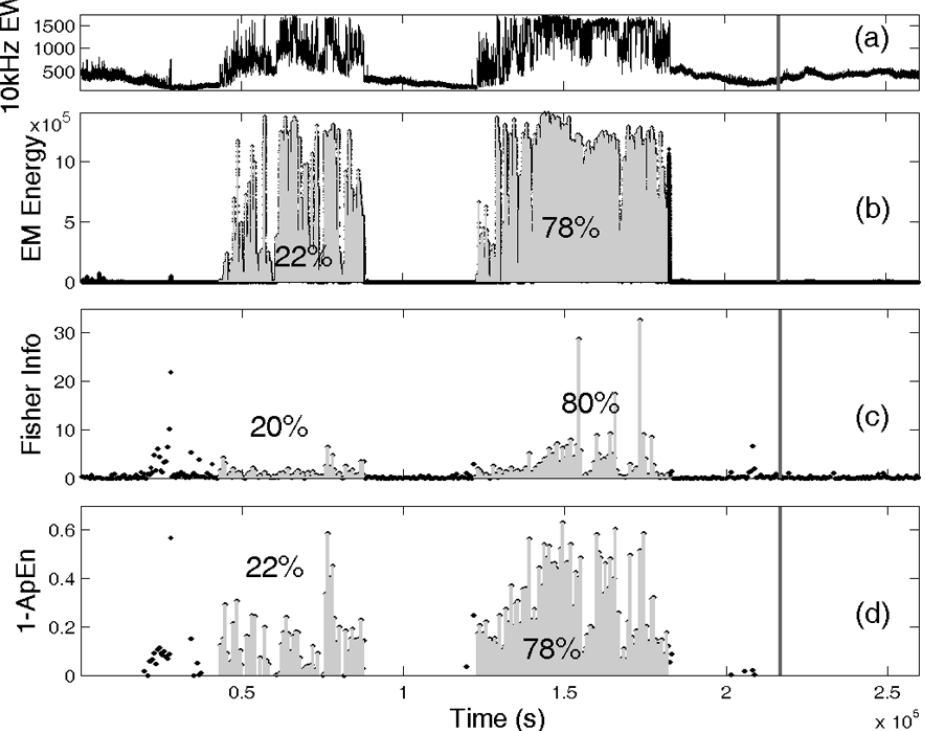
Fig. 1. (a) The two strong impulsive bursts in the tail of the recorded pre-seismic kHz EM emission (10kHz, East-West, magnetic field strength in arbitrary units) prior to Athens EQ (please refer to Fig. 1 in Papadimitriou et al., 2008). For the specific signal excerpt, the EM Energy (in arbitrary units) (b) , the Fisher information (c) and approximate entropy (d) evolution with time is presented. The grey areas indicate the energy, information and 1-ApEn corresponding to the two bursts. The first (left) burst is responsible for the 22% of the EM energy, the 20% of the Fisher information, and the 22% of the ApEn, while the second (right) for the 78%, 80%, and 78%, respectively. All graphs are time-aligned for direct reference. The time of the EQ occurrence is indicated by the thick, vertical grey